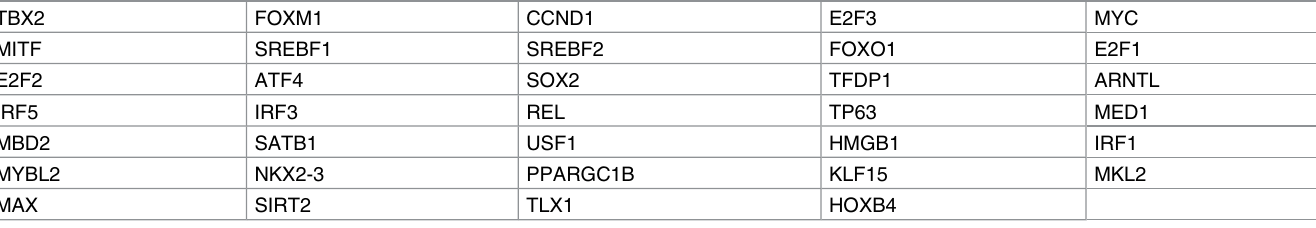
Table 2. Molecules Predicted to be Suppressed by TGF- β 3.